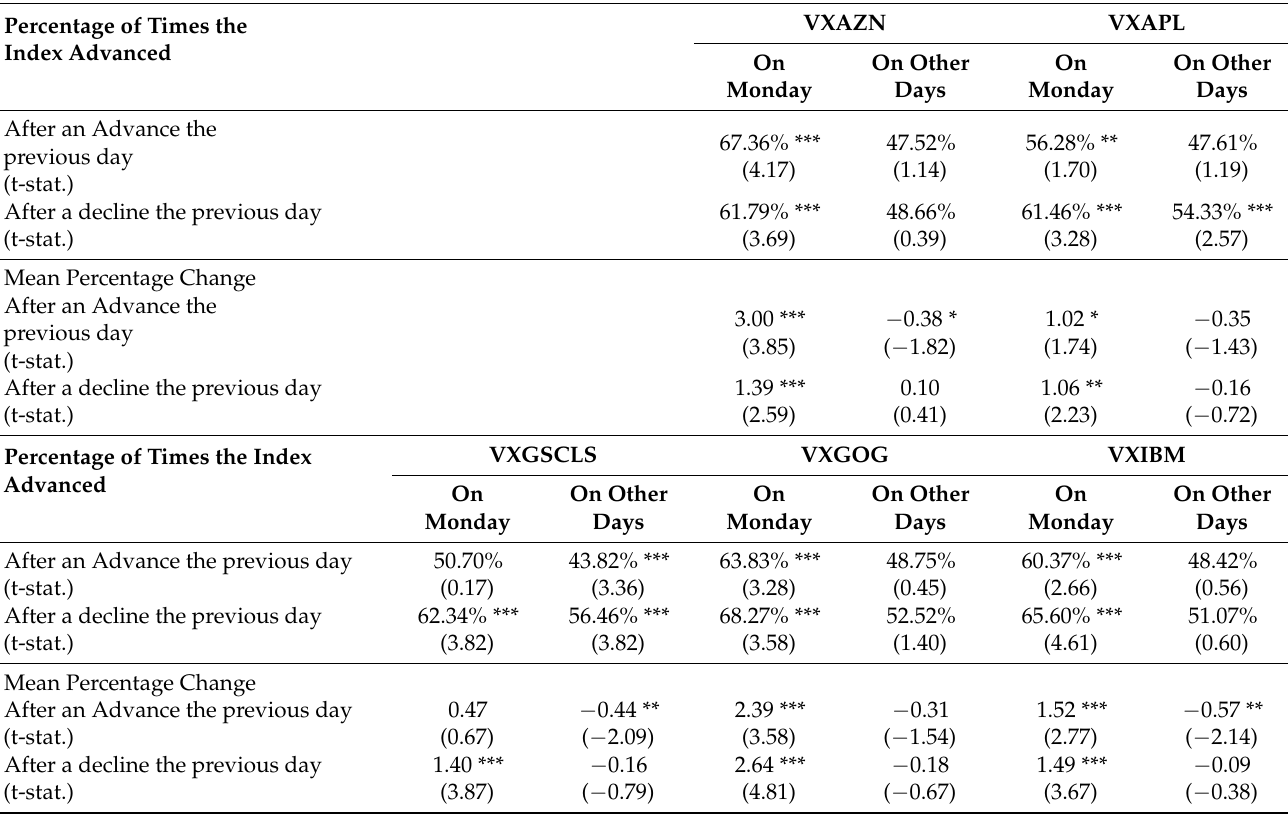
Table 8. A Comparison of changes in the VIX on Monday and on other days of the week contingent on the direction of change the previous